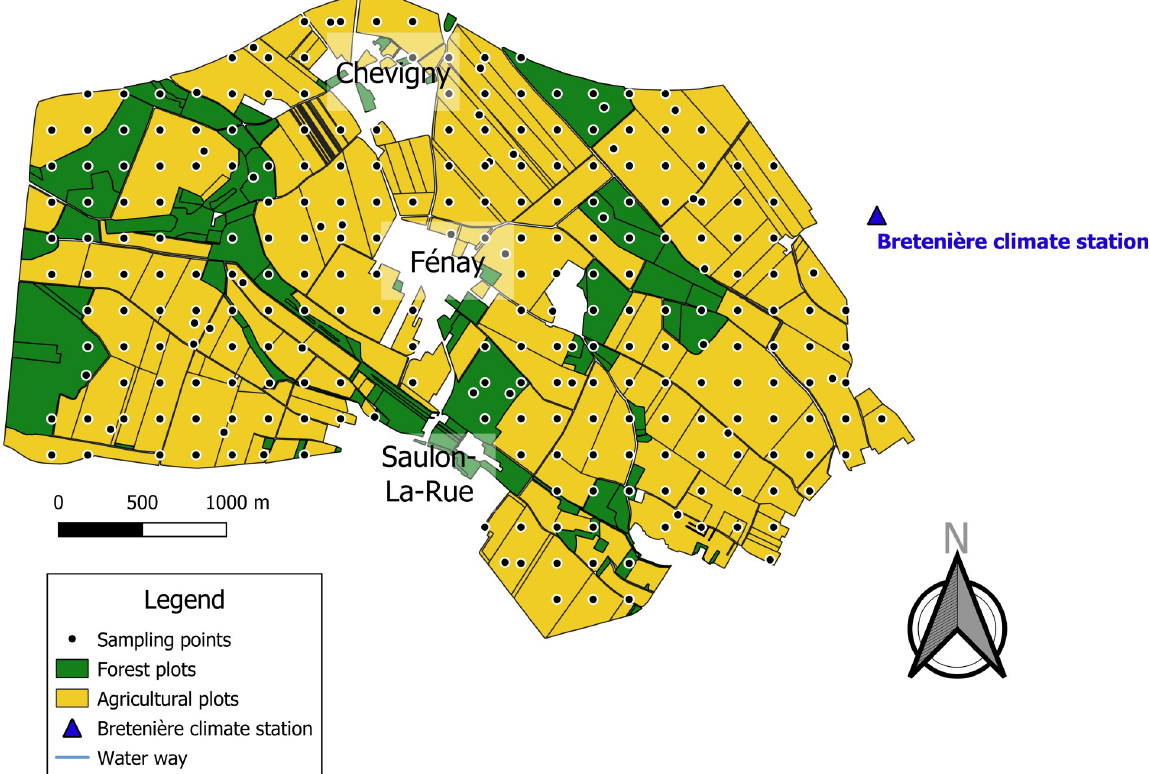
Fig 1. Map of the sampling points across the Fe´nay landscape, Burgundy, France. Green, forest plots; yellow, farmed plots. Black circles, sampling points; blue triangle, Breteni è re climate station. Blue lines are waterways.